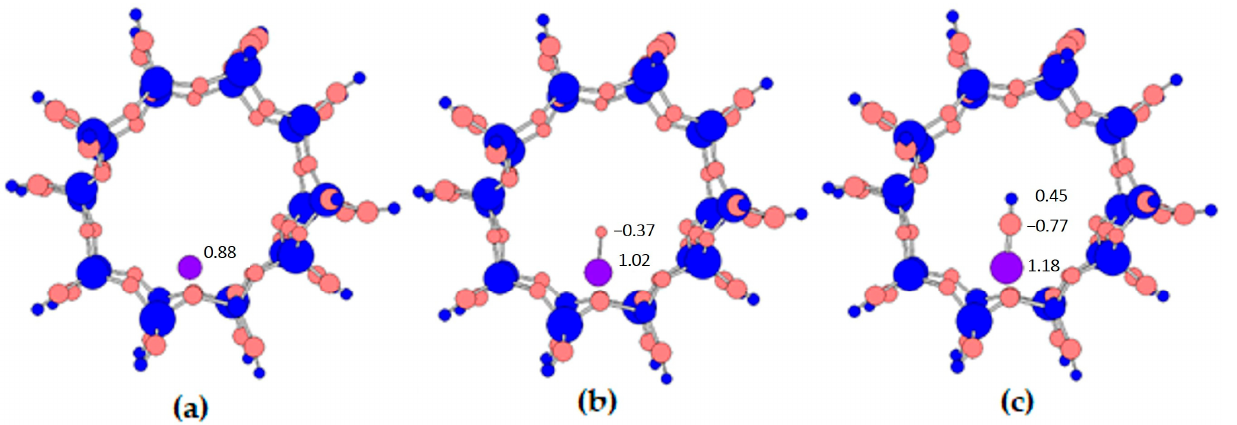
Figure 9. Visualized atomic charges derived from the Mulliken populations (blue—positive charge, red—negative charge): ( a ) ZSM-5 structure with Fe, ( b ) ZSM-5 structure with FeO, and ( c ) ZSM-5 structure with FeOH.